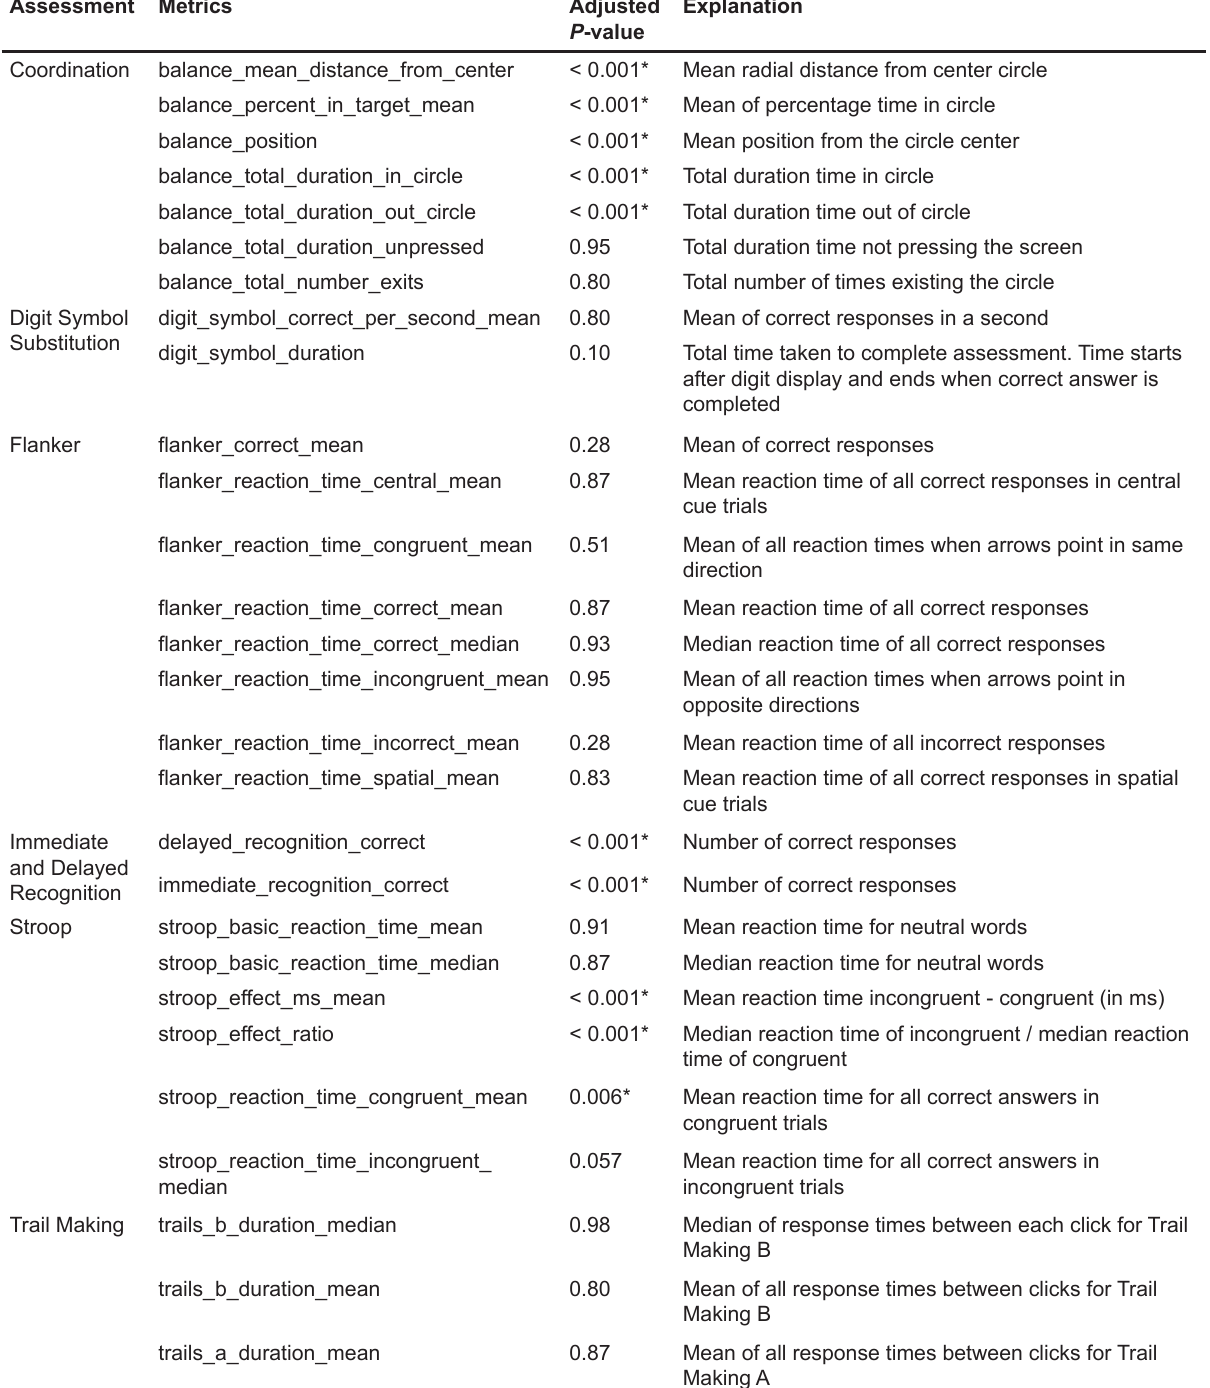
Table 2. Mann-Whitney U test comparison between the mTBI and control groups on the BrainCheck Battery assessment metrics, with Benjamini-Hochberg adjusted P